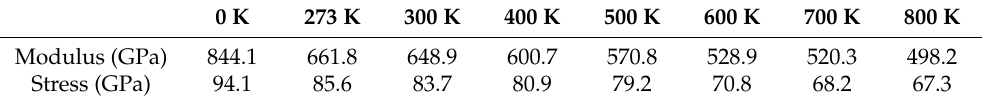
Figure 4. Stress–strain curves ( a ) and values ( b ) of perfect graphene at different temperatures. Table 3. Modulus and stress values of perfect graphene at different